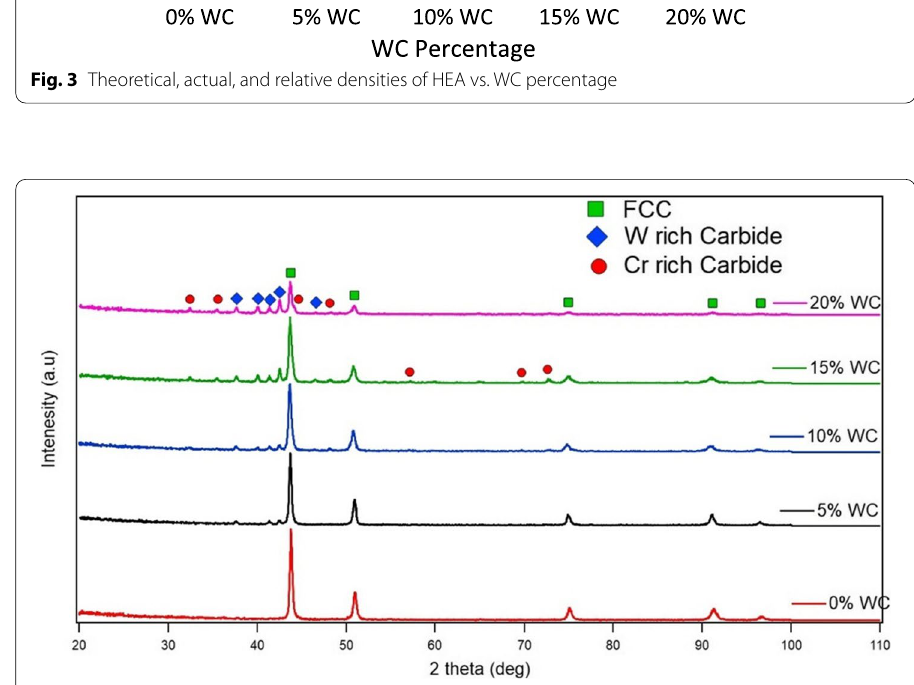
Fig. 4 XRD patterns of (CrFeCoNi) 1-x (WC) x ( x